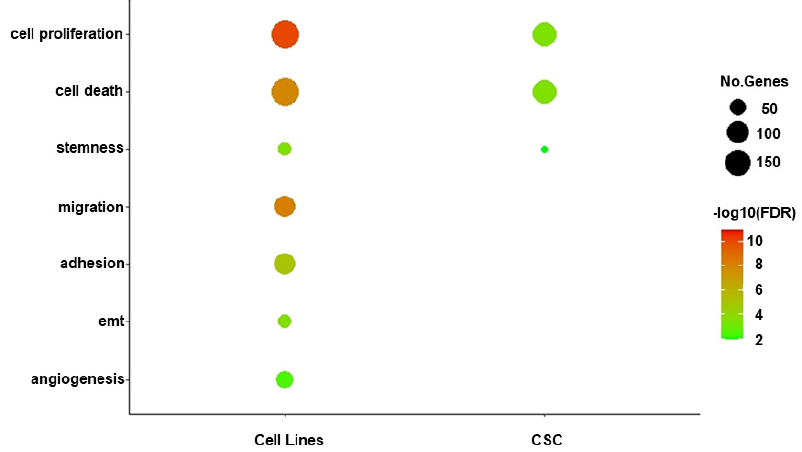
Figure 3. Functional enrichment analysis of miRNA target genes. Bubble plot shows a selection of biological functions of interest significantly enriched by miRNA target genes for GBM- and CSC-sEVs. Bubble size represents the number of target genes involved in each enriched function, while color gradient indicates statistical significance of the enrichment (FDR-BH, in log10 scale). Only significant enrichments are shown (FDR cutoff: 0.01).